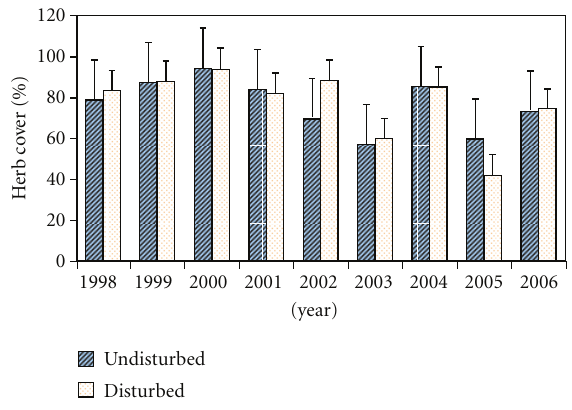
Figure 6: Herbaceous cover at disturbed and undisturbed sites in CKGR: 1998 to 2006. Error bars signify standard errors.